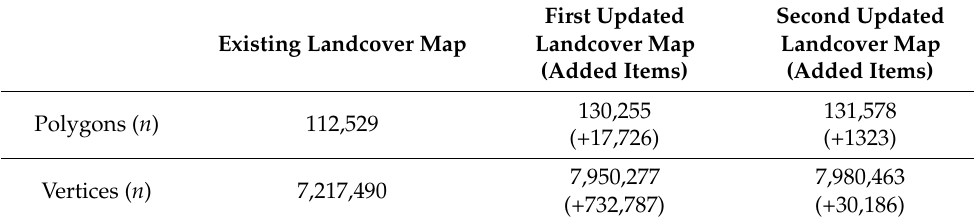
Table 5. Comparison of the number of polygons and